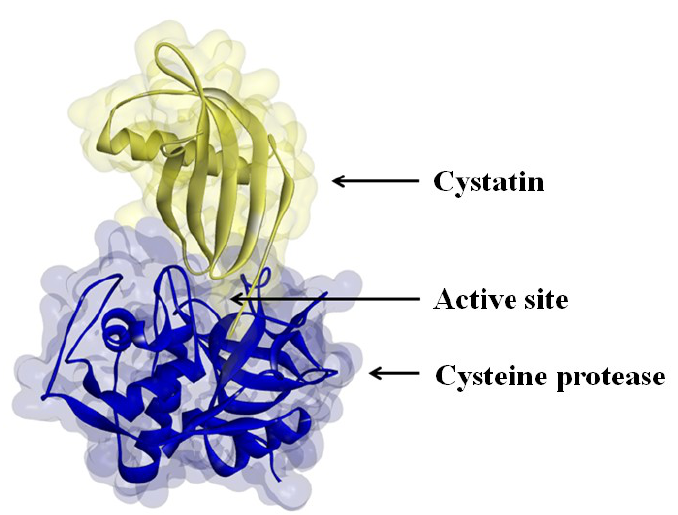
Figure 2. Cystatin binding to the active site of a cysteine